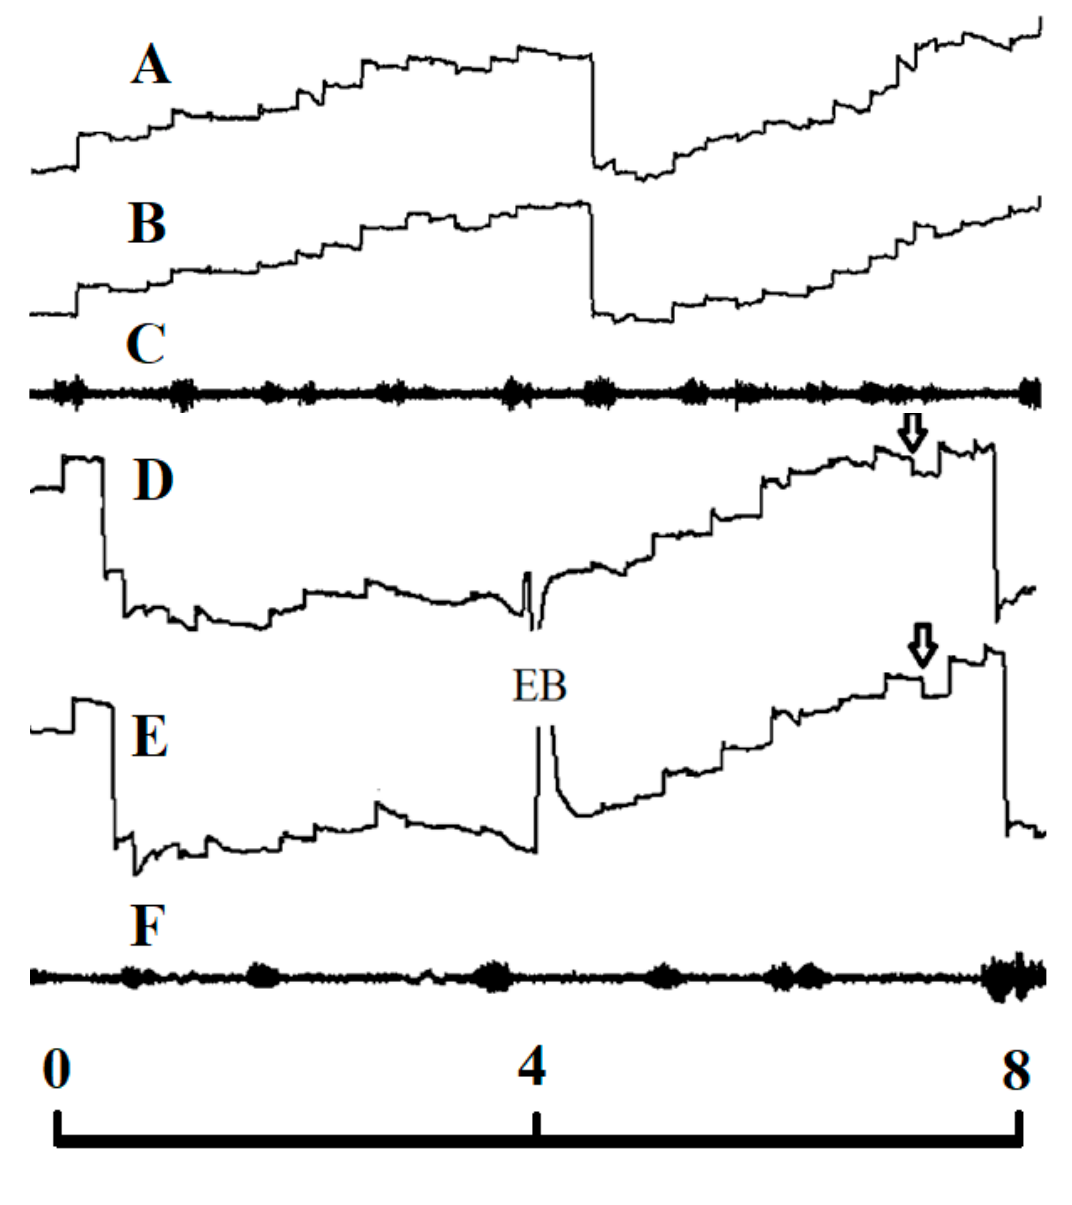
Figure 2. ( a , b ): Searching eye movements of a subject who participated in experiment 2 with many regressions during free reading. D and E: The subject exerts staircase-like eye movements with only one regression and longer fixation times during computer-guided reading. C: Speach spectogram during free reading; F: Speach spectogram during computer-guided reading. The speech spectogram (F) shows that the subject pronounces more slowly during computer-guided reading than during free reading (C). Figure 2 B: A and B: eye movements of a dyslexic reader who participated in experiment 2 during free reading. The subject exerts mainly staircase-like eye movements. D and E: staircase-like eye movements of the same subject during computer-guided reading with only one regression (arrow) and longer fixation times. C: Speach spectogram during free reading; F: Speach spectogram during computer guided reading. The speech spectrogram (F) shows that the subject pronounces more slowly during computer-guided reading than during free reading (C). Even if fixation time is prolonged up to 500 ms, some readers are unable to recognize more than 3 or 4 letters simultaneously. If slow reading is due to long fixation times, reading performance improves only if the reader does not try to recognize more letters simultaneously as s/he is able to. Otherwise long fixation times do not improve reading